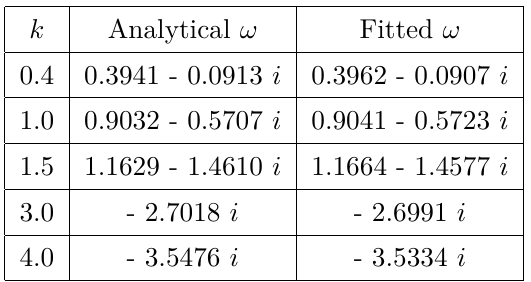
Table 2 . Comparison between the analytical sound frequencies from (A.4) and the fitted values of figure